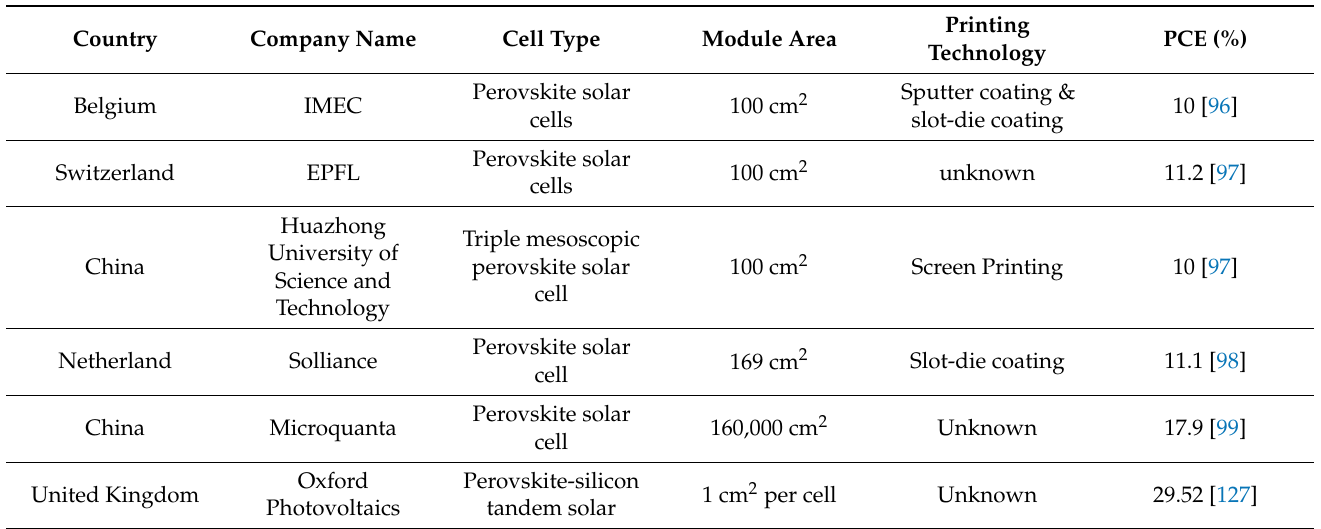
Table 7. Commercialisation status of